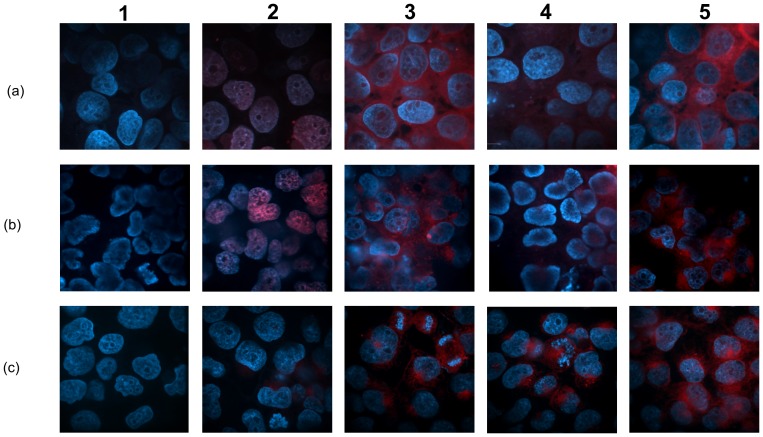
The intracellular localization of the drugs in JEG-3 and JAR cells and time-dependent drug uptake in JAR cells as exhibited by confocal laser scanning microscopy.Plots a1–5: JEG-3 cells; b1–5 and c1–5: JAR cells. For rows a & b, 1: Control; 2: Dox; 3: Ada-Dox; 4: NFACD-Ada-Dox; and 5: FACD-Ada-Dox. Plots c1–5 shows the time-dependent drug uptake with FACD-Ada-Dox for 0, 45, 75, 90 and 105 min. Images are merged from 2 channels 405Ex, 445Em for DAPI and 488Ex, 615Em for drugs. Both channels utilized the 445 (W60) and 615 (W70) filter sets, respectively. All images are 630 times of magnification with the same contrast adjustment applied across all samples. Images are representative of two independent experiments.